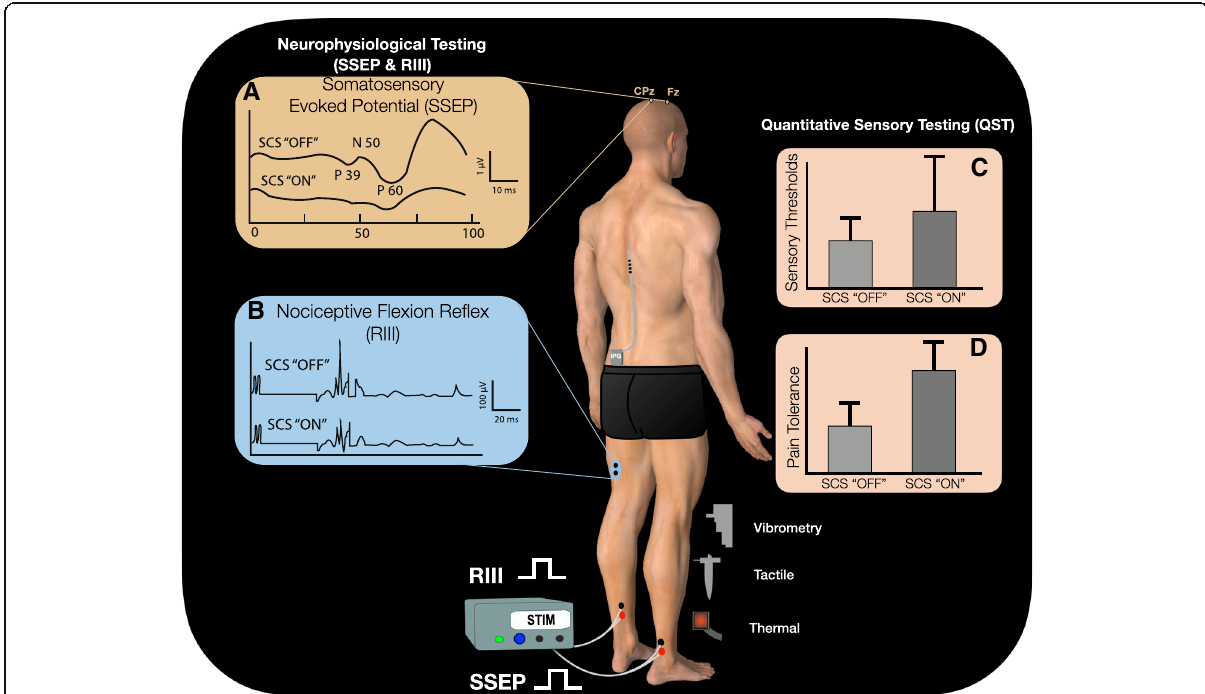
Fig. 7 Neurophysiological testing. Somatosensory evoked potentials (SSEP) waveforms are measured by applying an electrical stimuli to the tibial nerve. SSEP waveforms recorded with scalp electrodes at (CPz-Fz) are modulated with SCS. Panel a : During SCS ON P39-N50-P60 representative SSEP waveform decreases in amplitude. Flexor reflexes (RIII) are obtained with noxious electrical stimuli are applied to the sural nerve. The RIII waveform is recorded from the ipsilateral biceps femoris. Panel b : During SCS ON there is decrease the amplitude of the RIII waveform (adapted from (Sankarasubramanian et al., 2018b)). Quantitative sensory testing (QST) applies different sensory stimuli, such as vibratory, tactile or thermal stimuli to the subject extremity. Panels c , d : SCS results in variable effects on QST sensory thresholds and may increase increases pain threshold and tolerance. Advanced QST measures including temporal summation (TS) and conditioned pain modulation (CPM) can provide further insight into P-SCS, PF-SCS and DRG-S analgesic